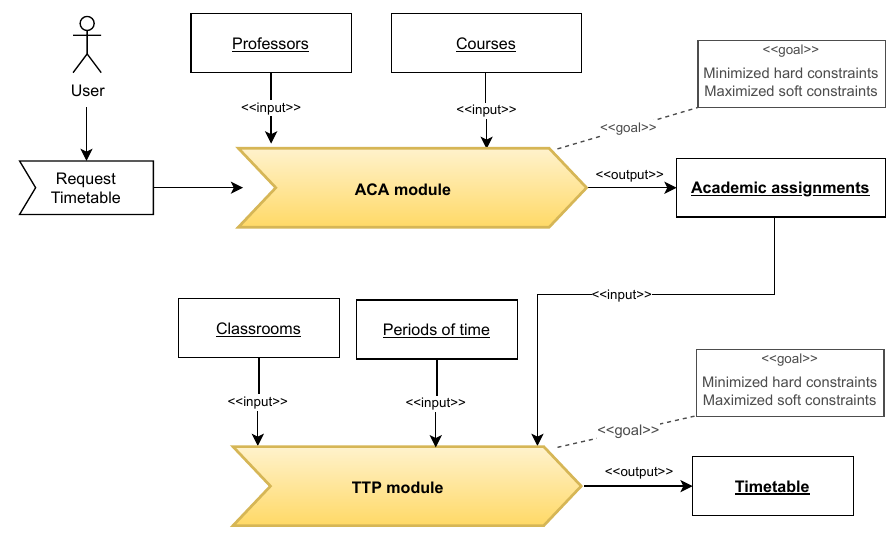
Figure 9. Process diagram.